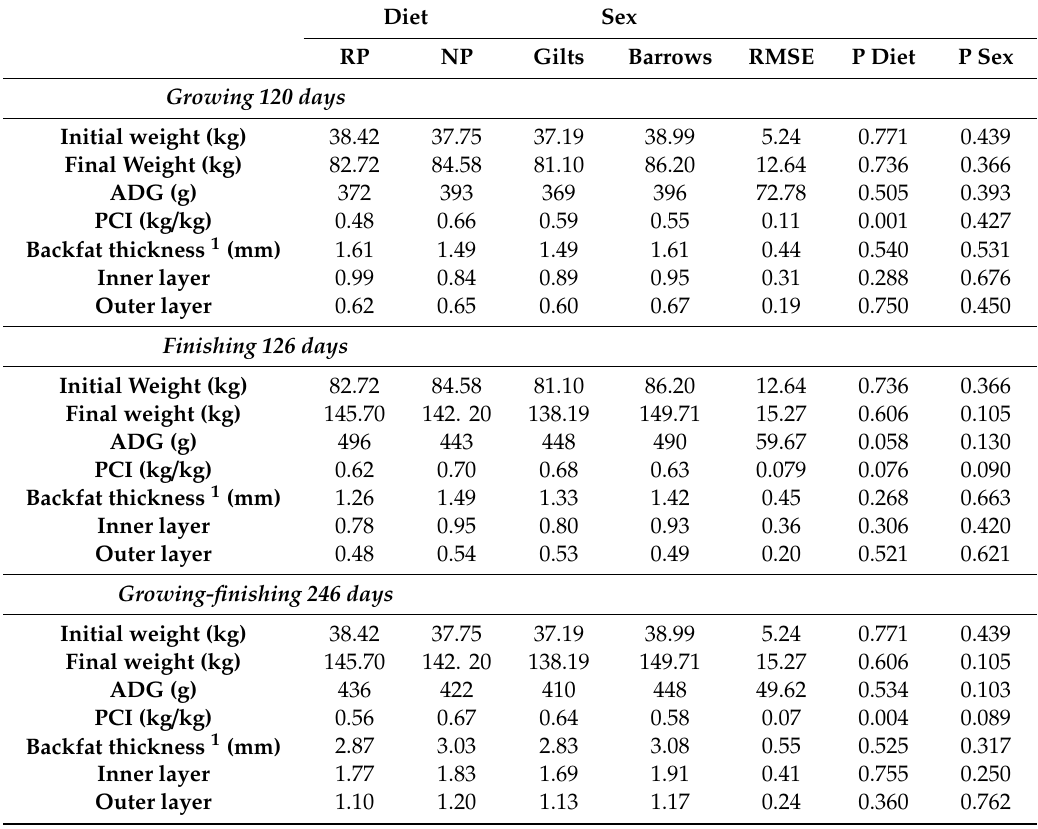
Table 2. E ff ects of protein restriction on Cinta Senese pigs: in vivo